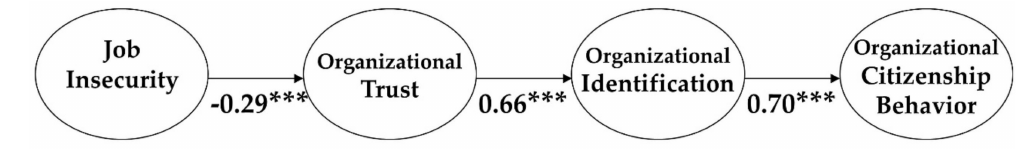
Figure 2. The standardized estimate values of the final model. Notes: *** p <